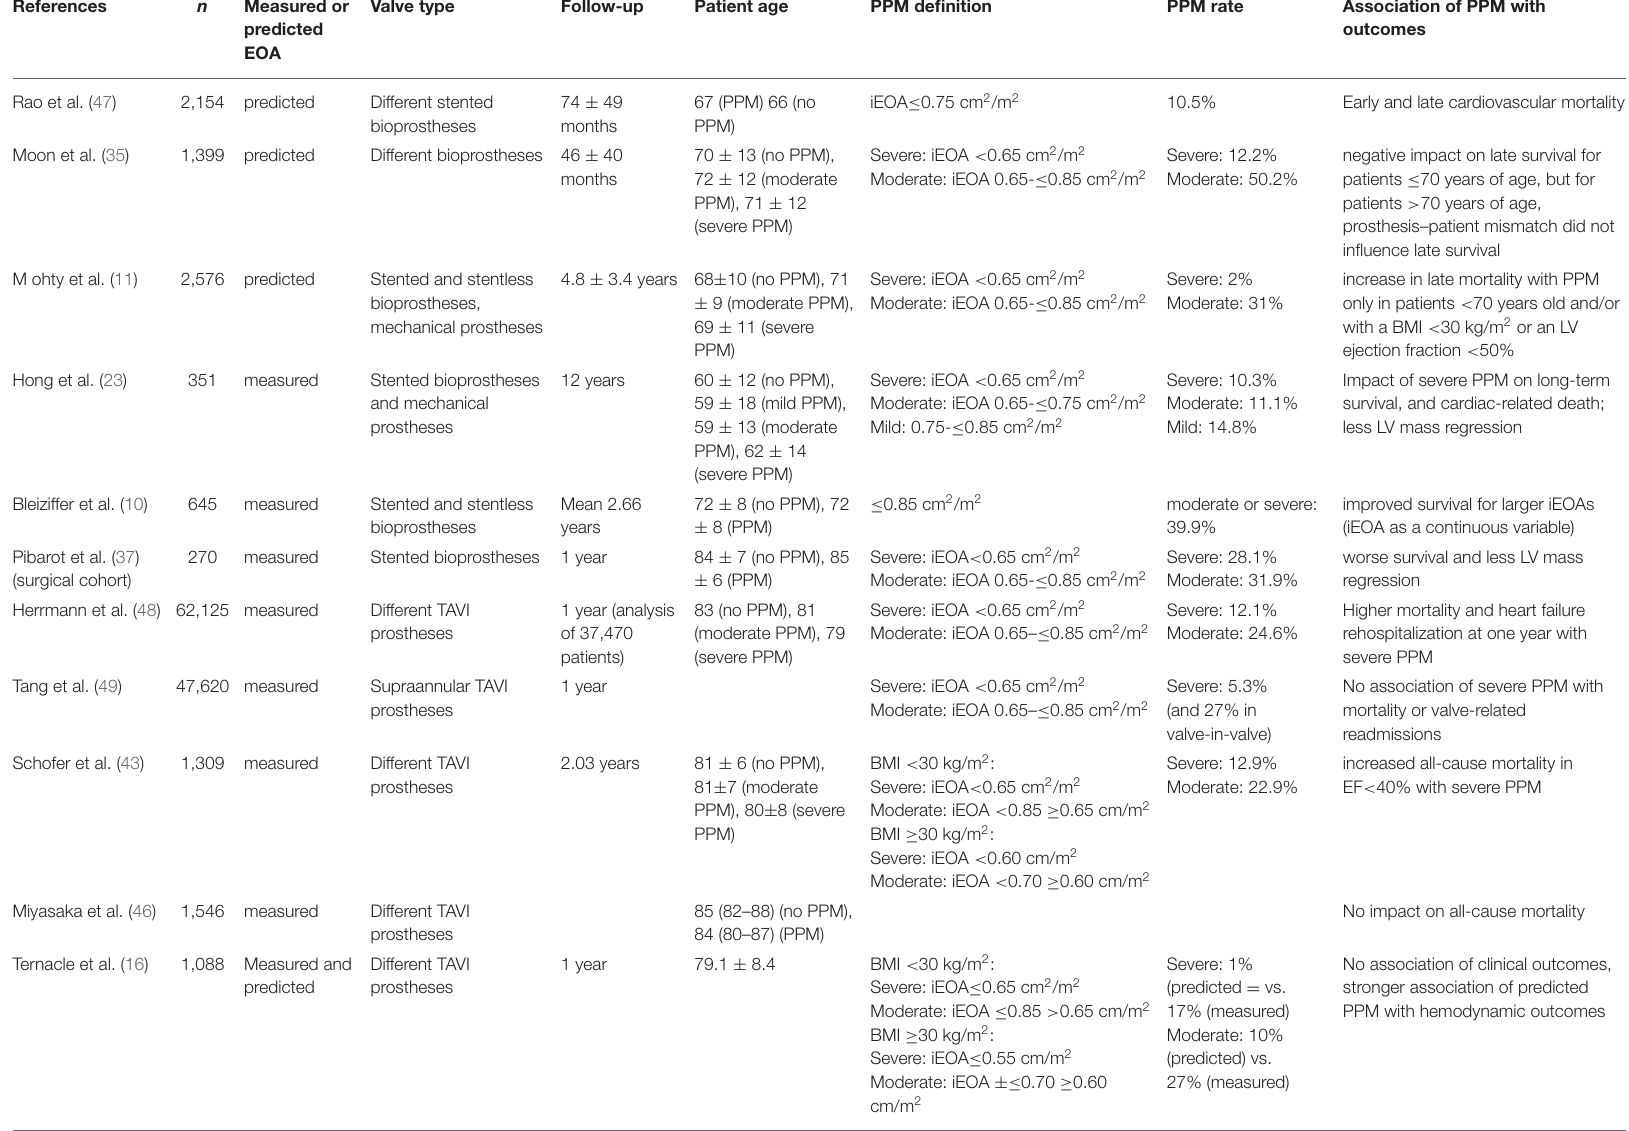
TABLE 3 | Impact of PPM in major original studies with predicted or measured